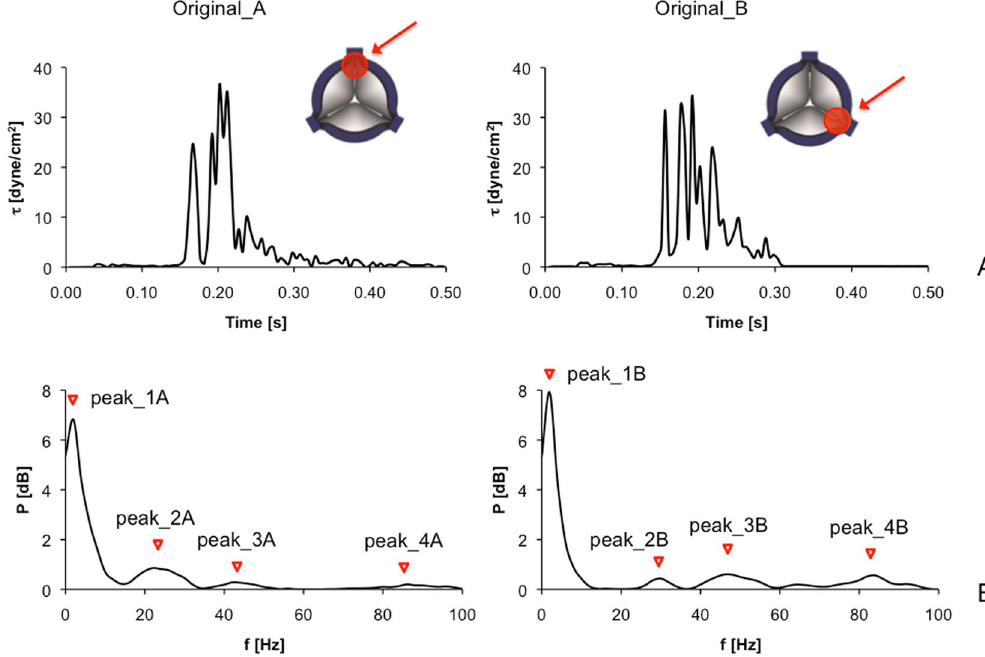
Figure 1. ( A ) Hemodynamic shear stress profiles characteristics of the trileaflet PHV are shown in the time- domain: the two curves, named Original_A (left) and Original_B (right) were computed from simulated trajectories of platelets flowing through two selected gap regions between the leaflet and the valve annulus 24 , indicated by arrows. ( B ) Power spectrum (PS) of the curves allows representing Original_A (left) and Original_B (right) in the frequency-domain: the principal frequency components of the PS are indicated by red triangles (Peak_1A–4A, Peak_1B–4B).